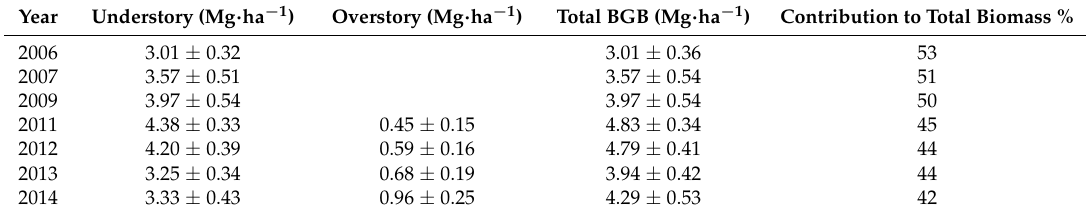
1 Values are the mean ± 1 standard error.